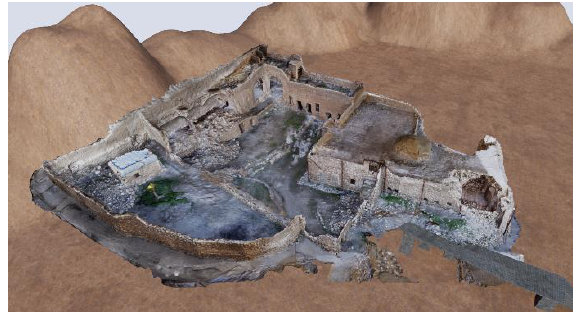
Figure 8. 3D model of Nahum´s shrine created by